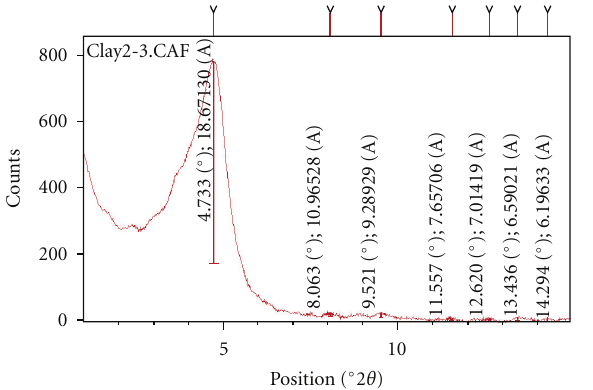
Figure 5: X-ray di ff raction curve of organoclay.